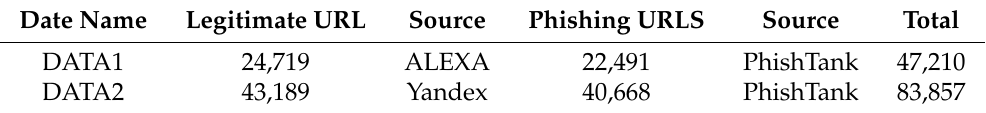
Table 2. URL Dataset used in our model.